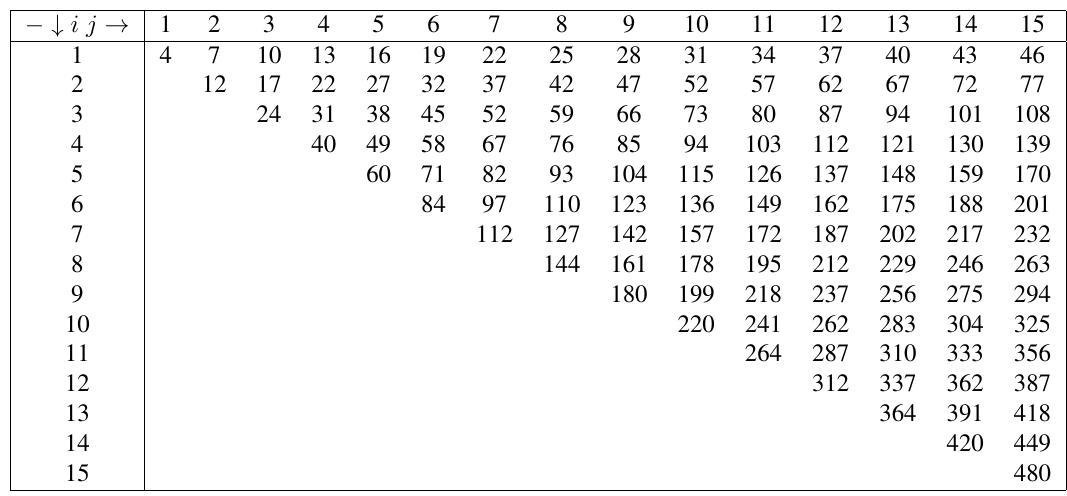
} for 1 ≤ i ≤ j ≤ 15 . i=row and j=column Table 8: Matrix K = { k ij